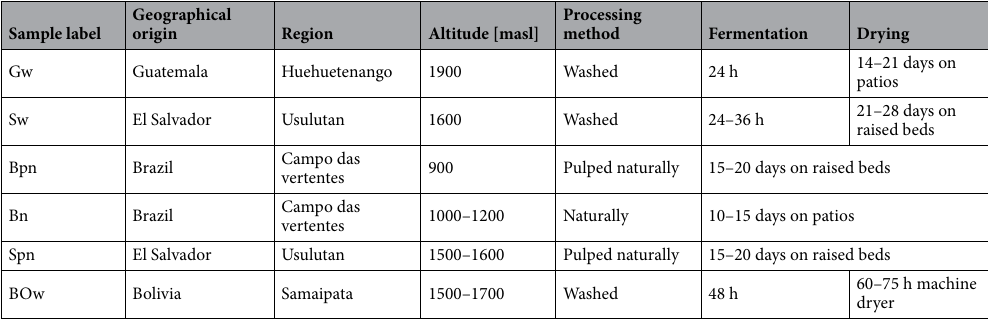
Table 4. The characteristic of studied coffee